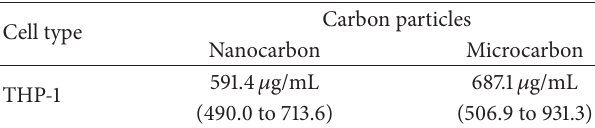
Table 3: Calculated TC-50